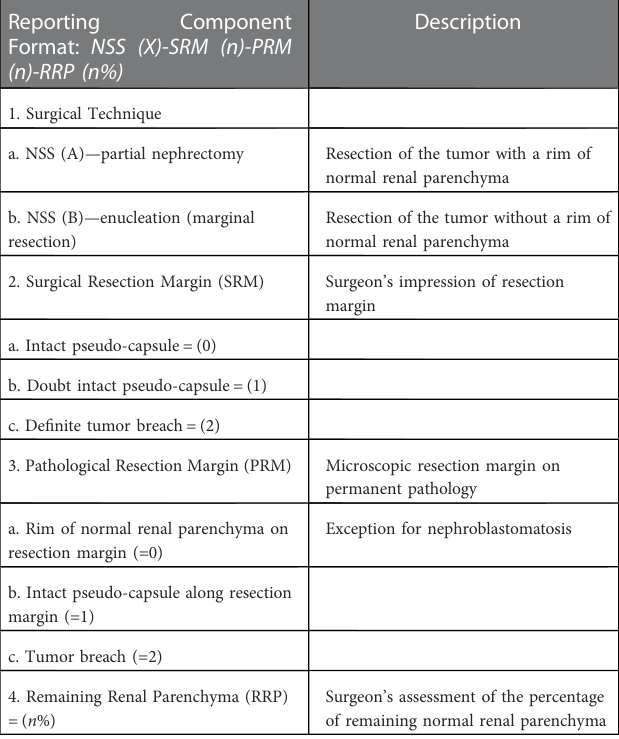
TABLE 1 International Society of Pediatric Oncology (SIOP) standardized reporting “ formula ” for nephron sparing surgery.